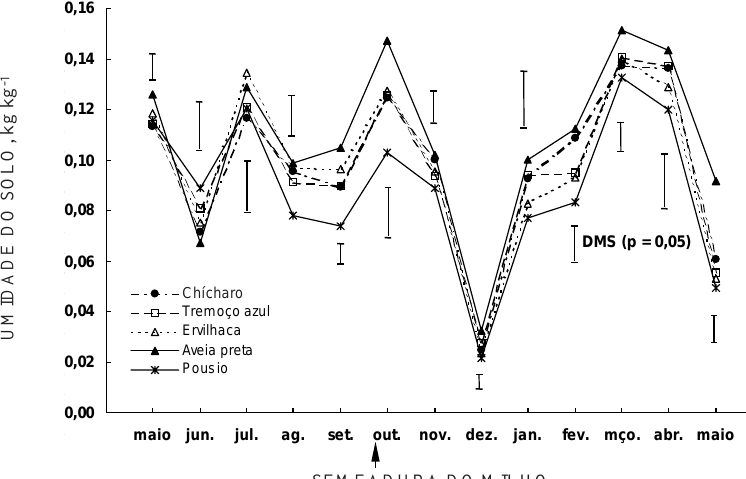
Figura 3. Variação temporal da umidade do solo, na camada de 0-5 cm, sob diferentes plantas de cobertura do solo antecedendo a cultura do milho em plantio direto. Diferença mínima significativa (DMS) pelo teste t (p =